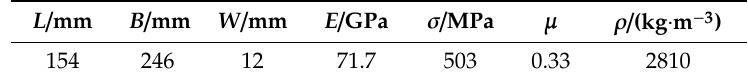
Table 1. Overall dimensional and material 7075 Al parameters of the mechanism.